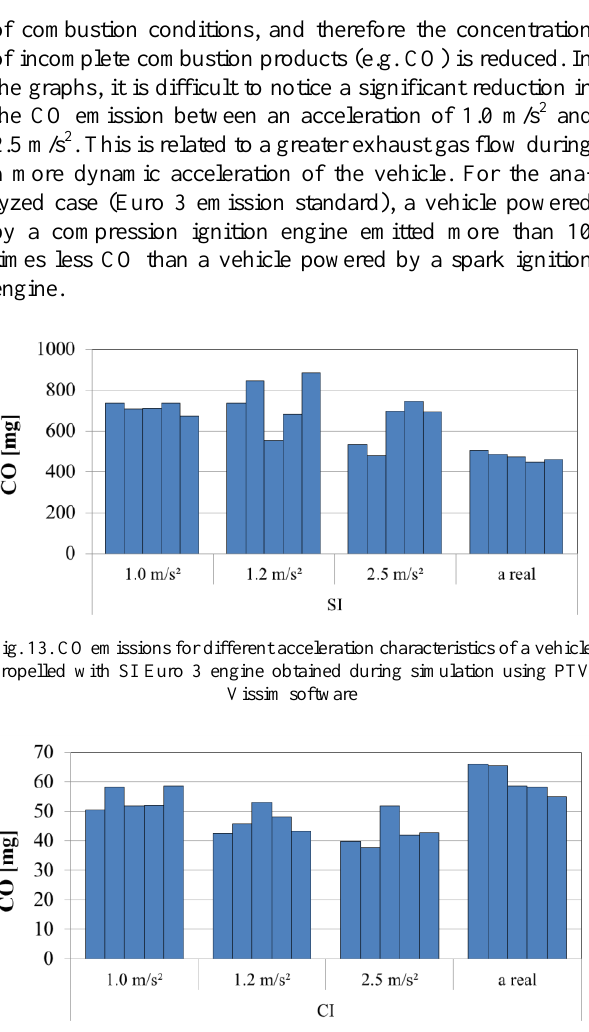
Fig. 14. CO emissions for different acceleration characteristics of a vehicle propelled with SI Euro 3 engine obtained during simulation using PTV Vissim